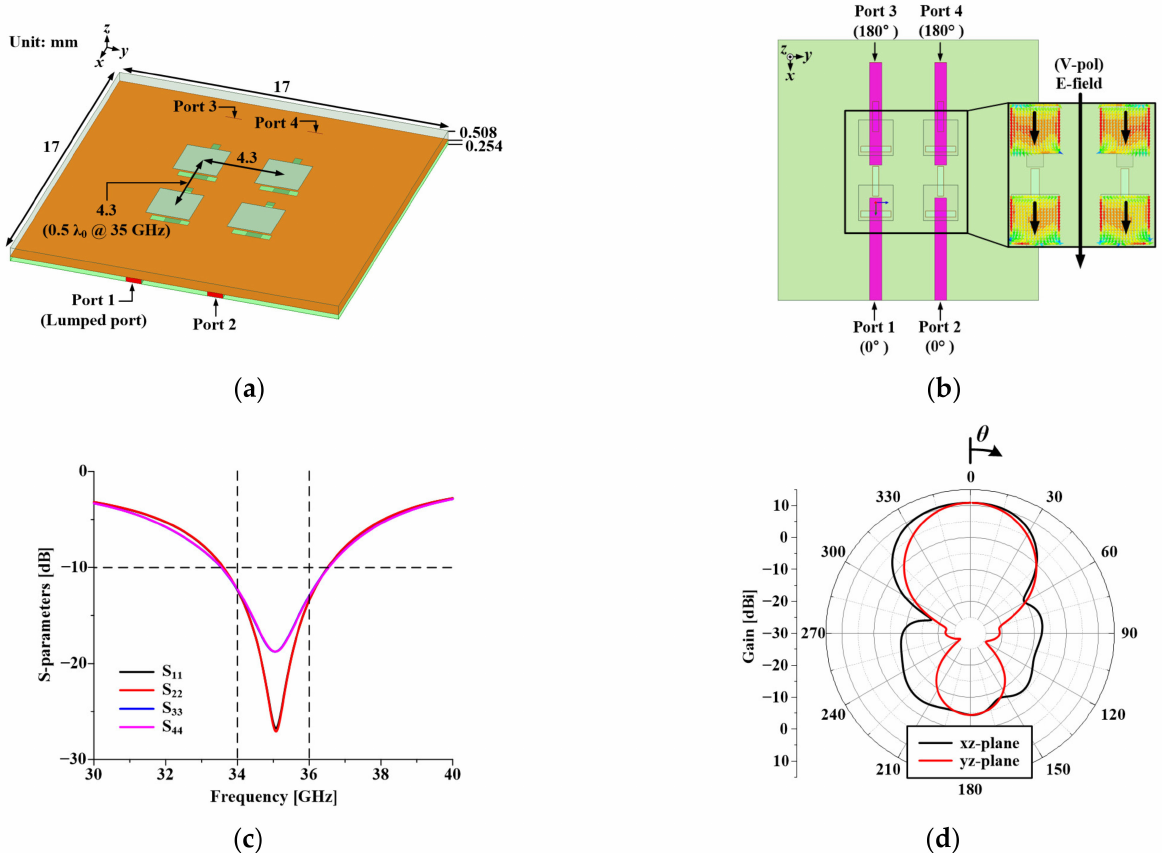
Figure 2. 2 × 2 patch antenna array for V-pol: ( a ) geometry of antenna array, ( b ) simulated surface current distribution at 35 GHz, ( c ) simulated reflection coefficient performances, and ( d ) simulated radiation patterns at 35